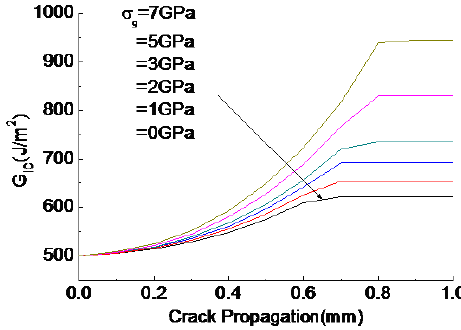
Figure 9. Effect of CNT@CF grafting tension stress on toughness improvement.